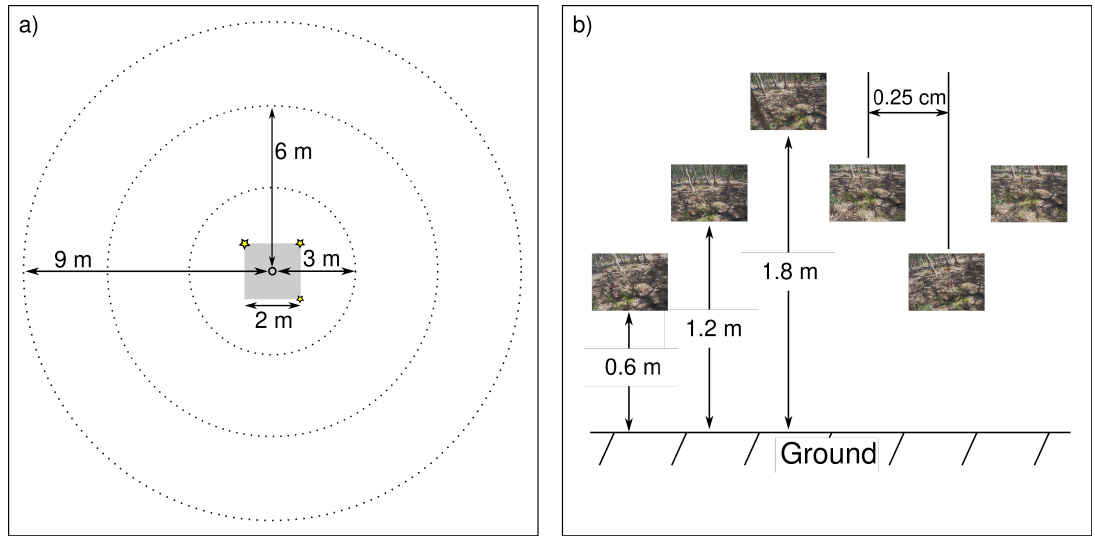
Figure 2. The plot layout showing ( a ) horizontal and ( b ) vertical distribution of the image network. Panel ( a ) shows the unobserved plot area in light grey, the imaging locations at all three distances as black dots, and the location of control targets as